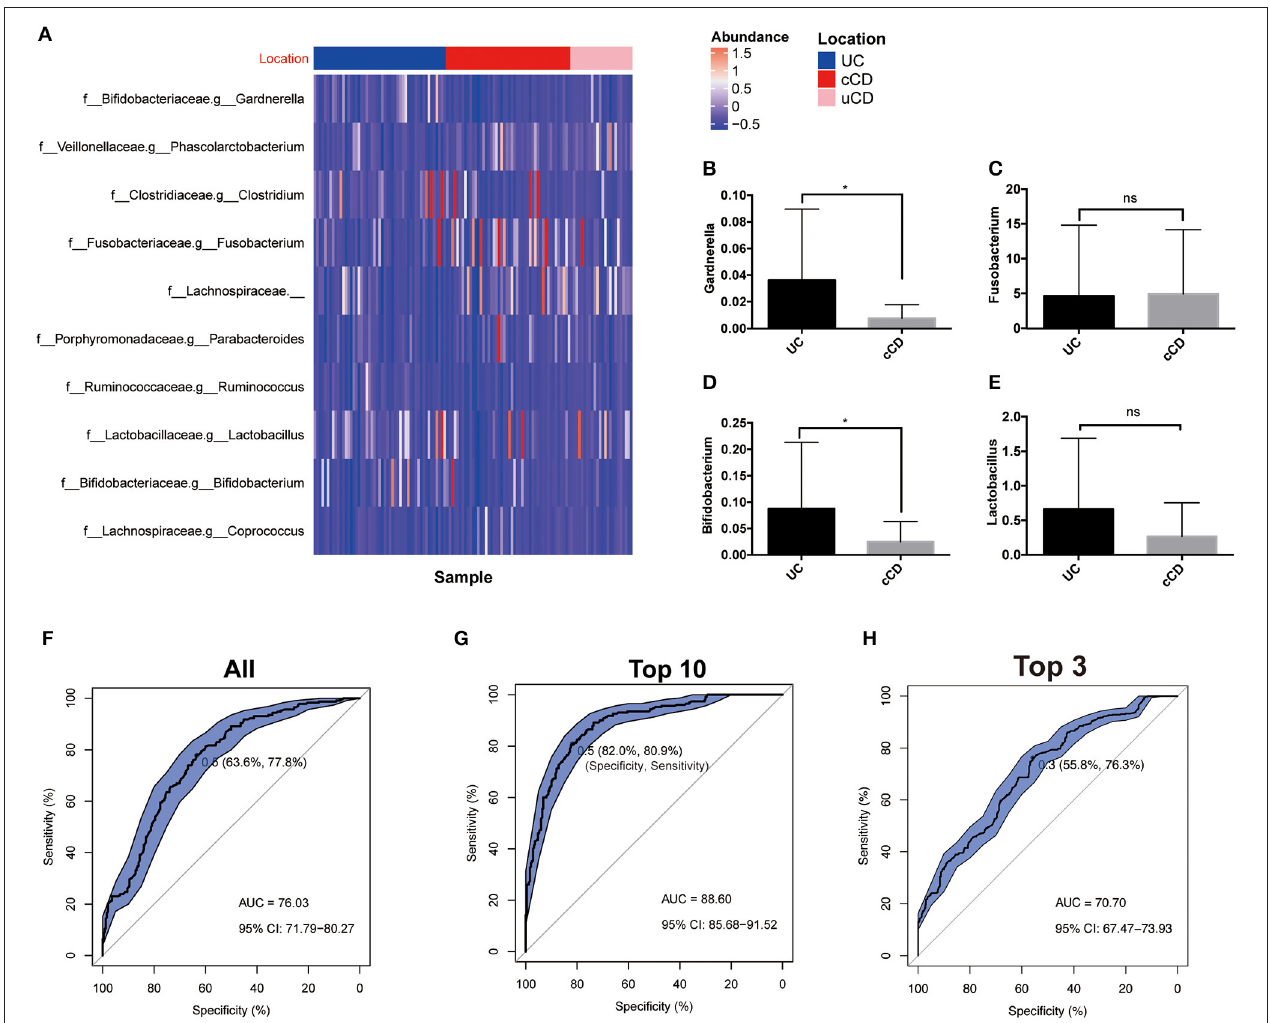
FIGURE 5 | (A) Gut microbiome profiles performed well for classifying IBD affected bowel region (UC, N = 51; cCD, N = 48). (B–E) Bacterial quantification targeting Gardnerella, Fusobacterium nucleatum , Bifidobacterium , and Lactobacillus quantified by qPCR (UC, N = 20; cCD, N = 21); (F–H) Receiver operating characteristic (ROC) plot with area under the curve (AUC) by all taxa in genus level (F) , top 10 taxa (G) and top 3 including Gardnerella and Fusobacterium (H) . cCD, colonic Crohn’s disease; nCD, non-colonic Crohn’s disease; UC, ulcerative colitis. *, p <